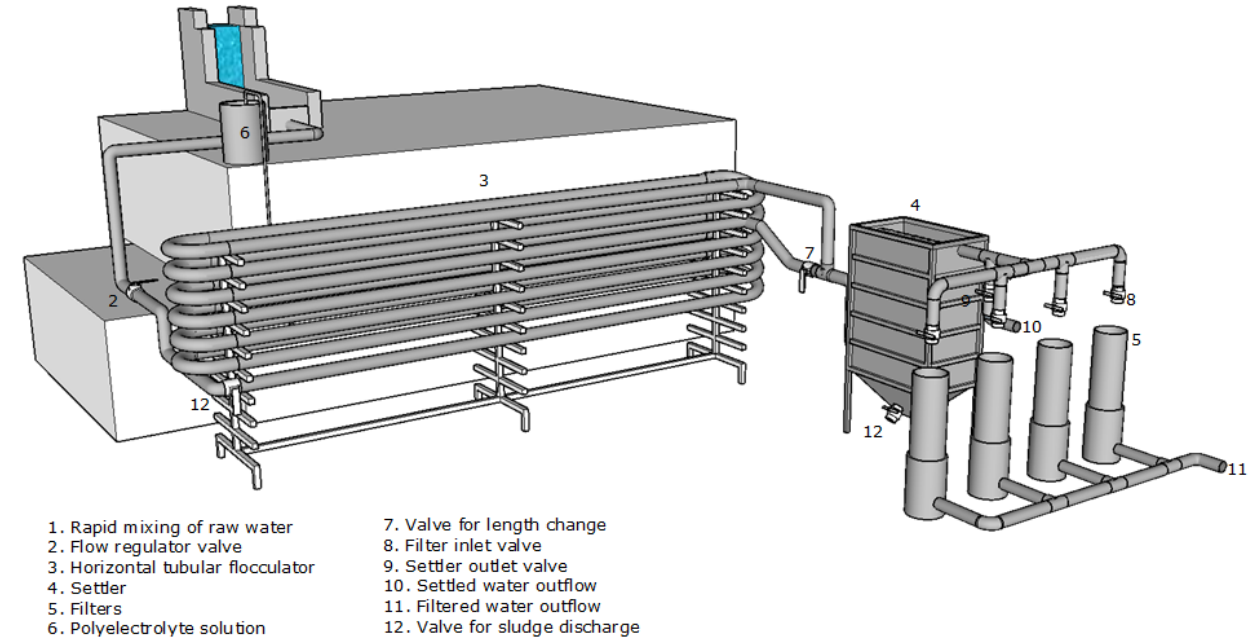
Figure 1. Pilot System that Includes HTF for the Potable Water